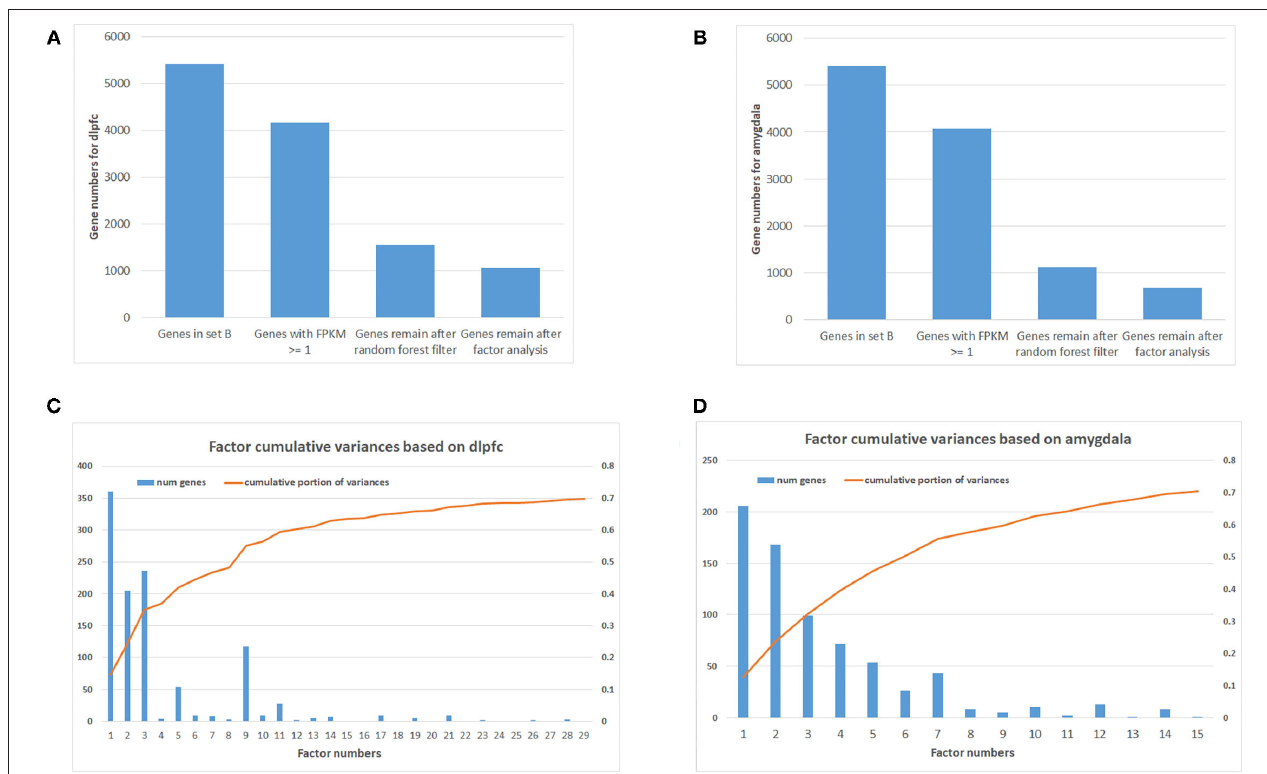
FIGURE 1 | Number of genes after filtering and factor analysis cumulative curve. (A) Number of genes after multiple filtering methods for dorsolateral prefrontal cortex (DLPFC). (B) Number of genes after multiple filtering methods for amygdala. (C) Factor analysis cumulative curve and number of remaining genes for DLPFC. (D) Factor analysis cumulative curve and number of remaining genes for amygdala.